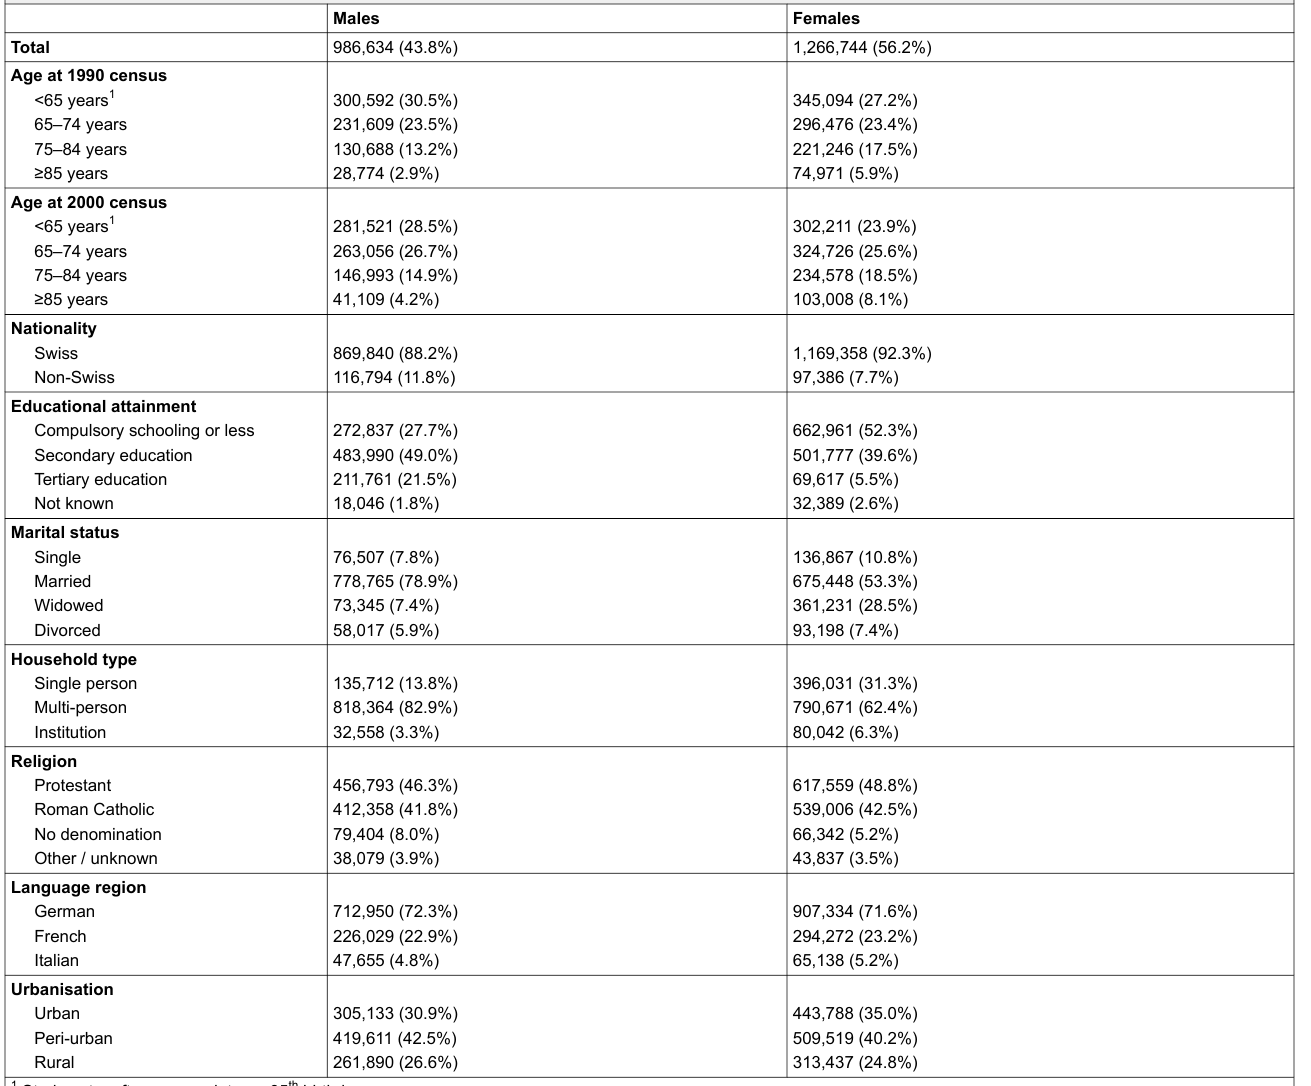
Table 1: Characteristics of the analytic study population (older Swiss adults ≥65 years old), 1991–2008. Males